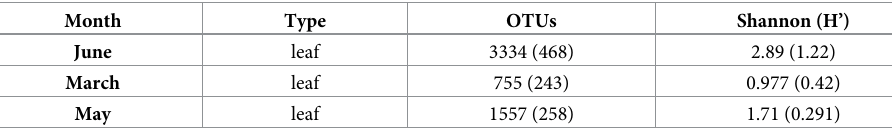
Table 1. Mean (SD) values for alpha diversity metrics for each study